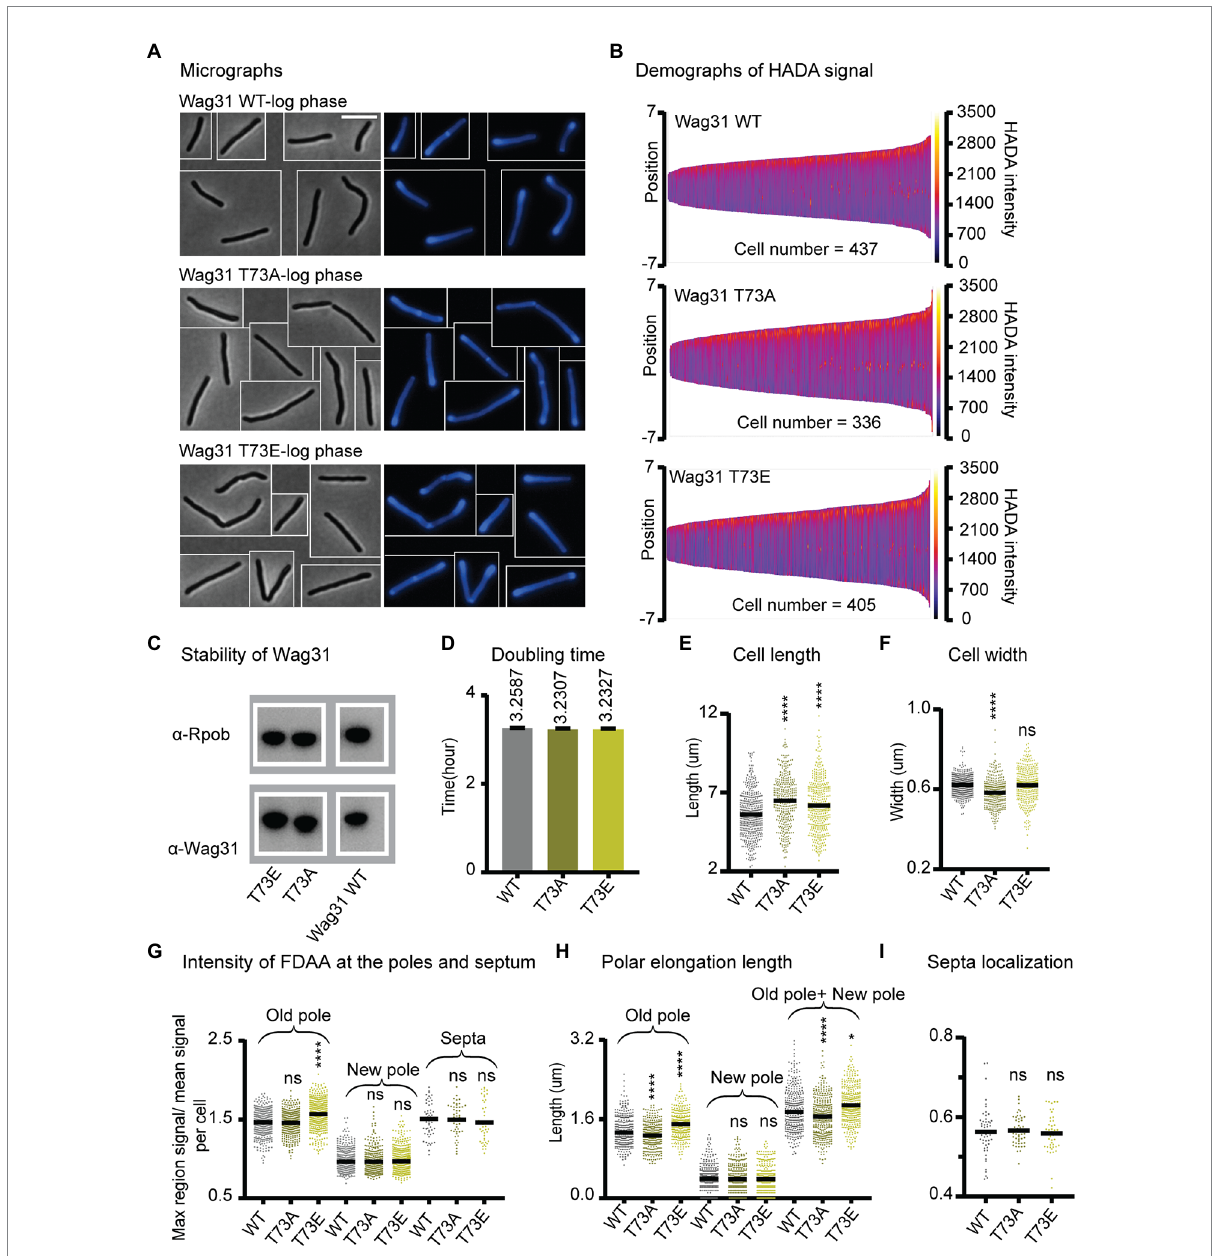
FIGURE 3 Phosphorylation of T73 on Wag31 subtly affects the cell wall metabolism, but does not affect growth rate. (A) Phase (left) and fluorescence (right) images of Msmeg wag31 allele strains stained with HADA. The scale bar is 5 microns, and it applies to all images. (B) Demographs of HADA intensity (color scale) across the length of the cell (Y axis) of the wag31 allele strains. The cells were sorted by length, with shortest cells on the left and longest on the right of each demograph. Cells were also pole-sorted according to HADA intensity, such that the brighter pole (presumed to be the old pole) was oriented to the top along the Y axis. At least 100 cells were analyzed from each of three independent biological replicates of each strain. (C) Western blots of Wag31 WT, T73A, and T73E proteins in wag31 allele strains using α -Wag31 antibody. RpoB serves as a loading control. (D) Doubling times of Msmeg cells expressing WT or wag31 mutants. The means (on top of bars) are an average of three biological replicates. Error bars represent SD. (E) Cell lengths of the wag31 allele strains. Black bars are at the mean. (F) Cell widths of the wag31 allele strains. Black bars are at the mean. (G) Relative polar and septal HADA intensity of wag31 allele strains. Relative intensity is equal to the maximum signal at a cell pole, divided by the mean signal of that cell. (H) Length of polar elongation in the wag31 allele strains, as measured by the elongation assay method diagrammed in Figure 1I. (I) Septal location in wag31 allele strains. Black bar is at the median. ns, p > 0.05, **** p = < 0.0001. All p -values were calculated by one-way ANOVA, Dunnett’s multiple comparisons